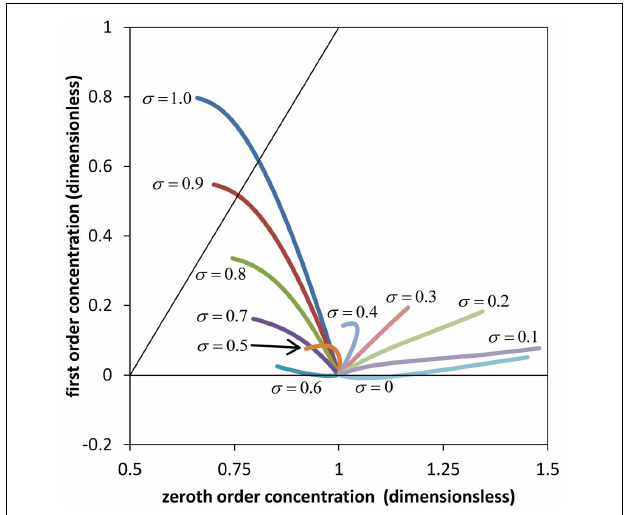
FIGURE 3 | Comparison of zeroth and first order results. Average solute concentration for different values of the reflection σ and axial position ˆ z between ˆ z = 0 and ˆ z = ˆ z max (see Figure 2 ). All curves start at ˆ z = 0 ) = 1 and ˆ c ˆ z = 0 ) = 0. Parameters of Table 1 were used for the ˆ c 0 ( 1 ( numerical calculation. The diagonal indicates same order of magnitude of zeroth and first order coefficients in the power series